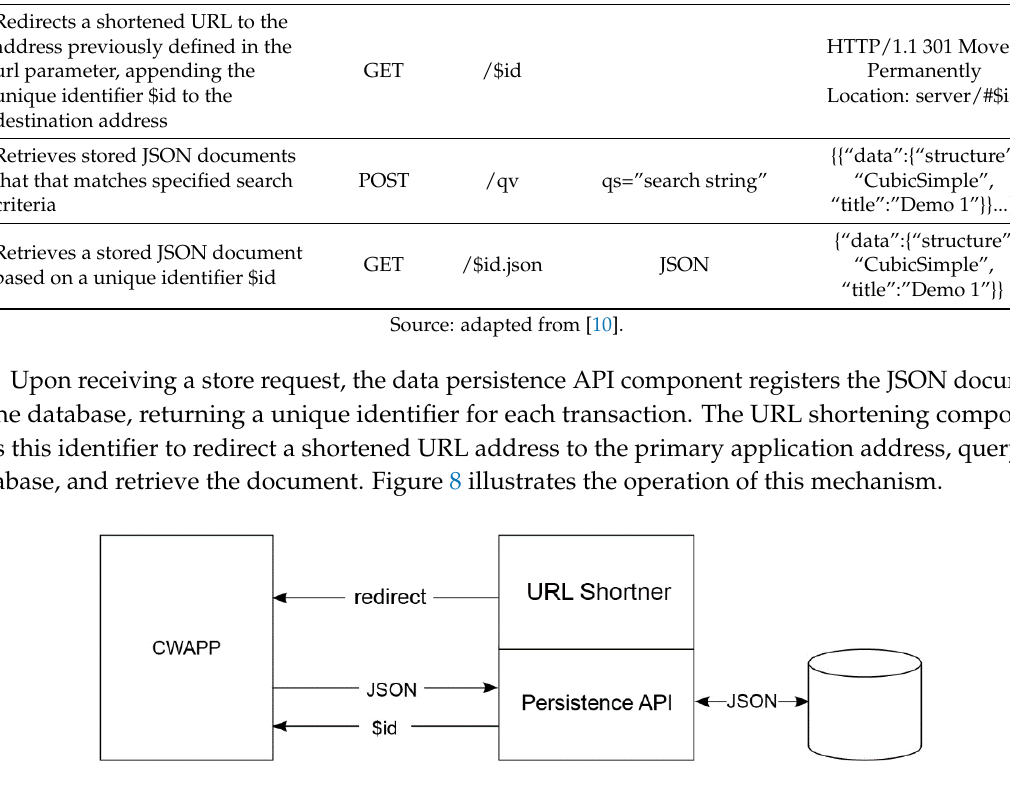
Table 3. Description of routes, verbs and parameters of the CWLY REST interface.